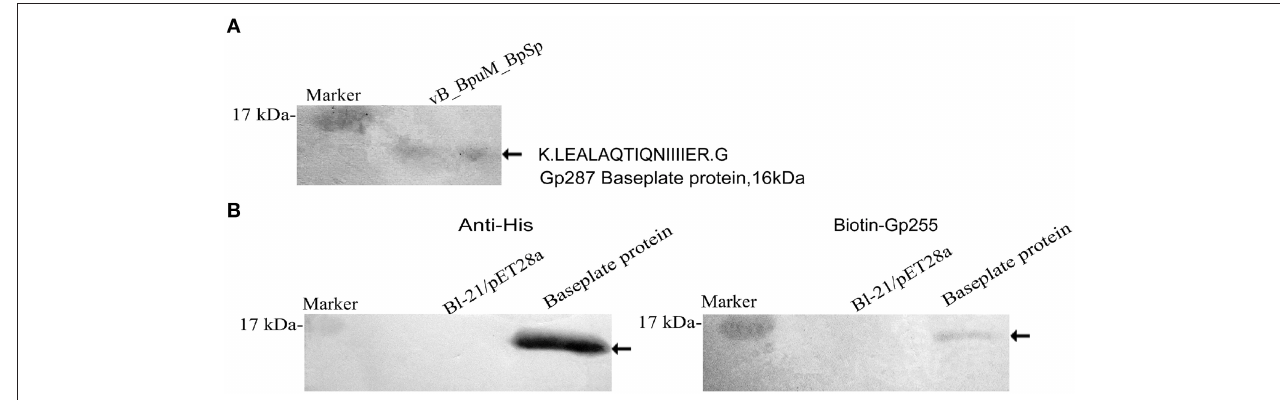
FIGURE 6 | Identification of the phage structural protein that interacted with Gp255. (A) Identification of the interacting protein of Gp255 in phage vB_BpuM_BpSp structural proteome. The virions of phage vB_BpuM_BpSp were separated by SDS-PAGE and biotin-labeled Gp255 was used for Far-western blotting analysis. The detected protein band was identified by MALDI-TOF/-TOF MS. The identified peptide and corresponding protein encoded by phage vB_BpuM_BpSp are indicated. (B) Verification of the interaction between Gp255 and Gp287. Purified Gp287 were separated by 15% SDS-PAGE. E. coli strain BL-21/pET28a was used as control. Western blotting was carried by using the antibody of 6 × His-tag and the biotin-labeled Gp255, respectively. The detected hybridization bands are indicated.